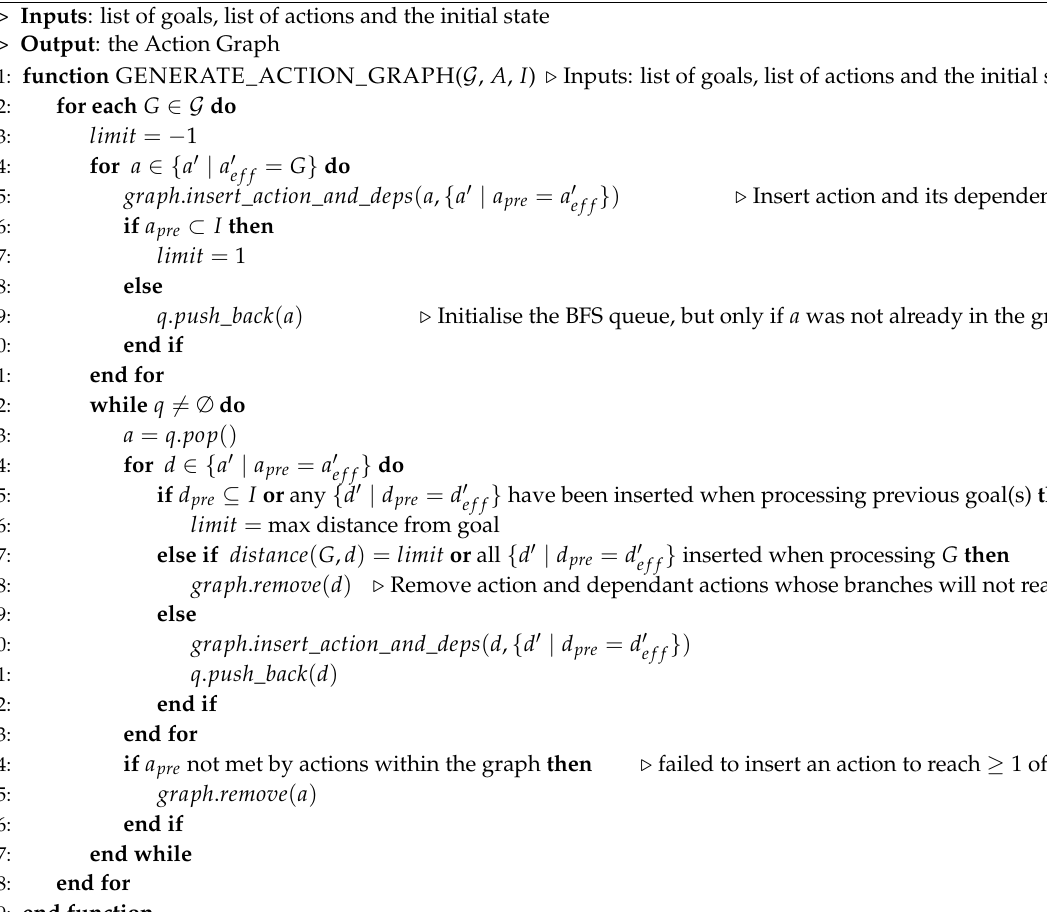
Algorithm A1 BFS for generating an Action Graph containing optimal